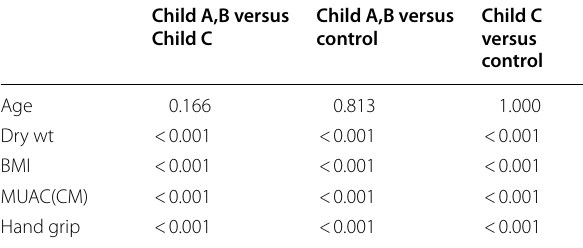
Table 5 Posthoc pairwise comparison ( P value between each 2